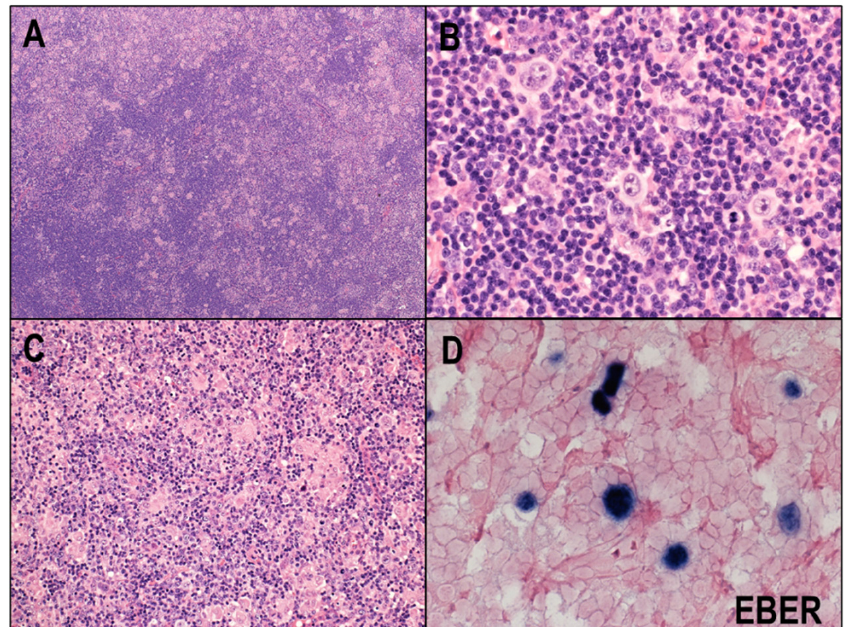
Figure 3. Mixed cellularity classic Hodgkin lymphoma (MCCHL). ( A ) MCCHL lacks a thickened lymph node capsule and broad bands of fibrosis (HE × 40). ( B ) HRS cells in MCCHL show a classic appearance (HE × 400). ( C ) The background cells may contain abundant epithelioid histiocytes, and epithelioid granulomas can be observed (HE × 100). ( D ) MCCHL is highly associated with EBV ( × 400).